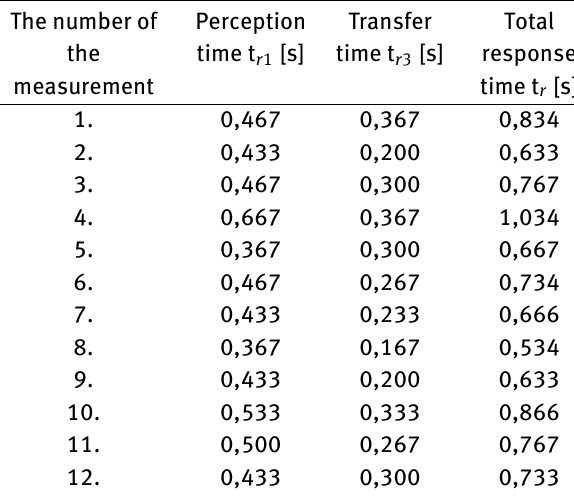
Table 8: Summary of the results of driver